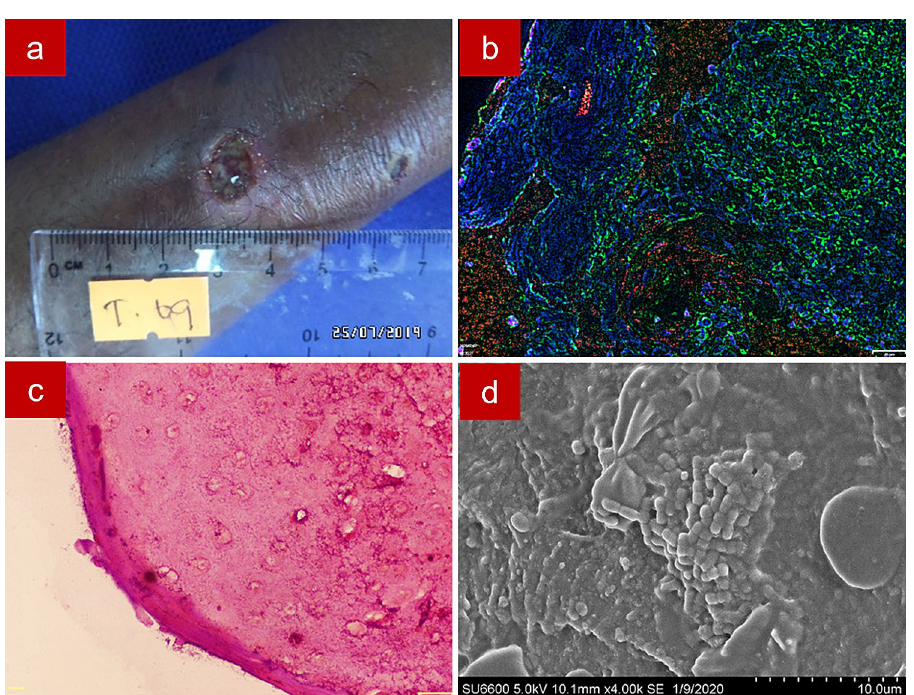
Figure 7. Sample 7. Image of a wet ulcer of 12 weeks duration in the lower limb ( a ); Fluorescence in situ hybridization showing bacteria in red with the CY3 tagged Eu bacterial probe, extracellular polymeric substances in green with Concavalin A conjugated Alexa Fluor 488 and tissue nuclei in blue with DAPI ( b ); Gram staining showing gram positive cocci ( c ); Scanning electron microscopy showing coccoid shaped bacteria in chains embedded in smooth extracellular polymeric substance ( d